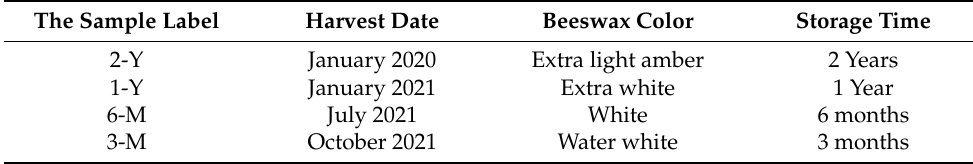
Table 1. General information about the studied beeswax samples.